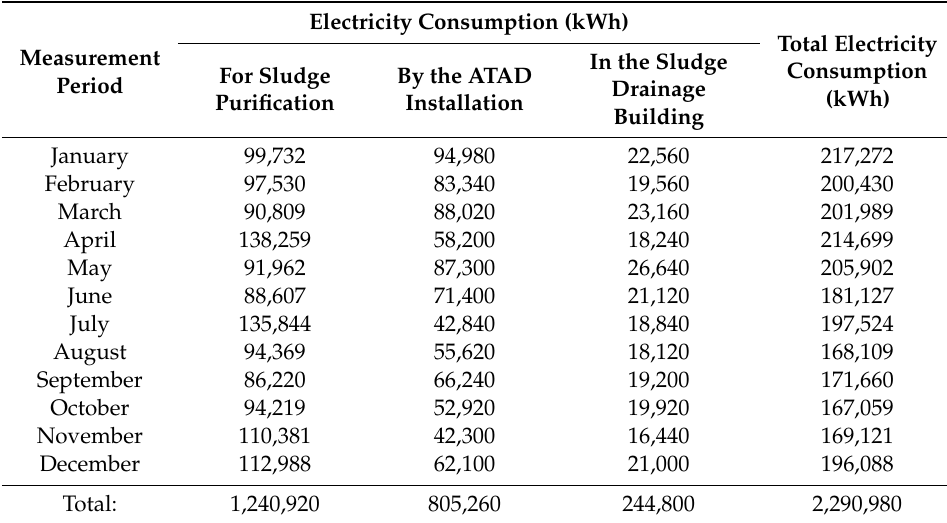
Table 4. Annual electricity consumption balance